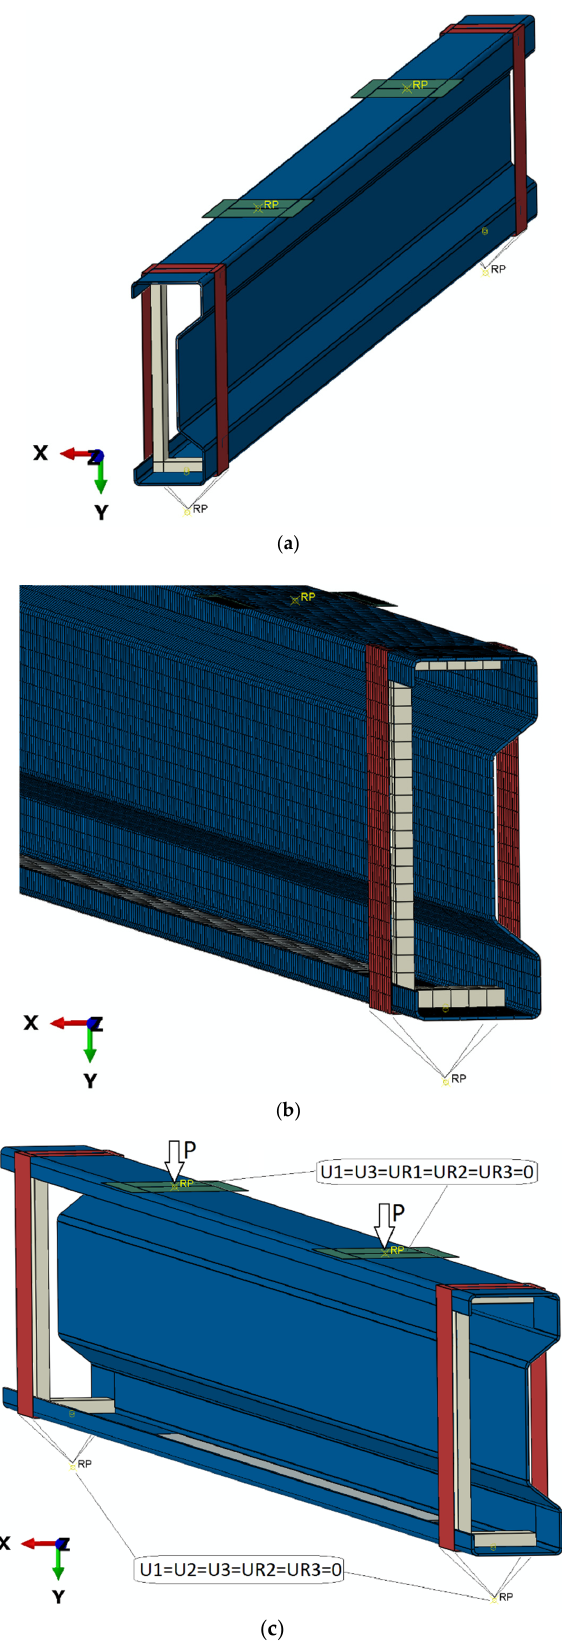
Figure 12. Numerical model of beam: ( a ) shell model; ( b ) discrete model; ( c ) boundary conditions of model.